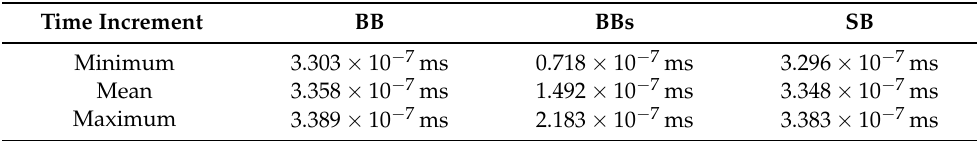
Table 3. Smallest, largest and mean time increment during the simulation for the three investigated tire patterns.